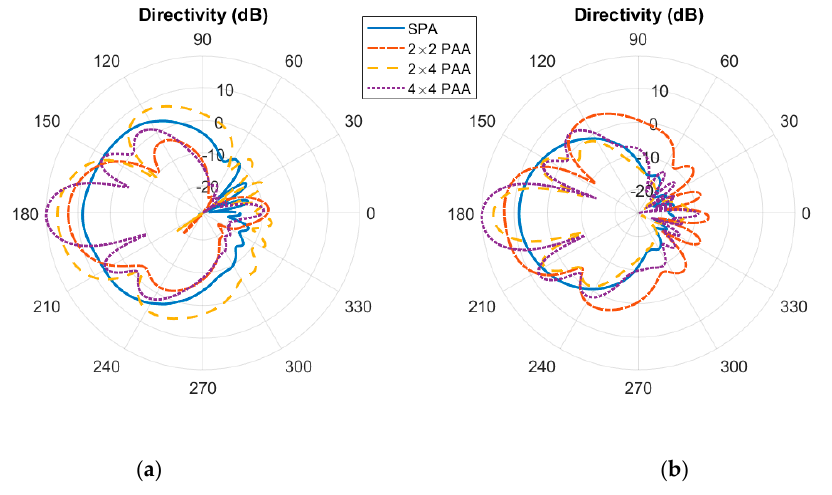
Figure 3. Radiation pattern of patch antenna arrays: ( a ) E-plane; ( b ) H-plane.